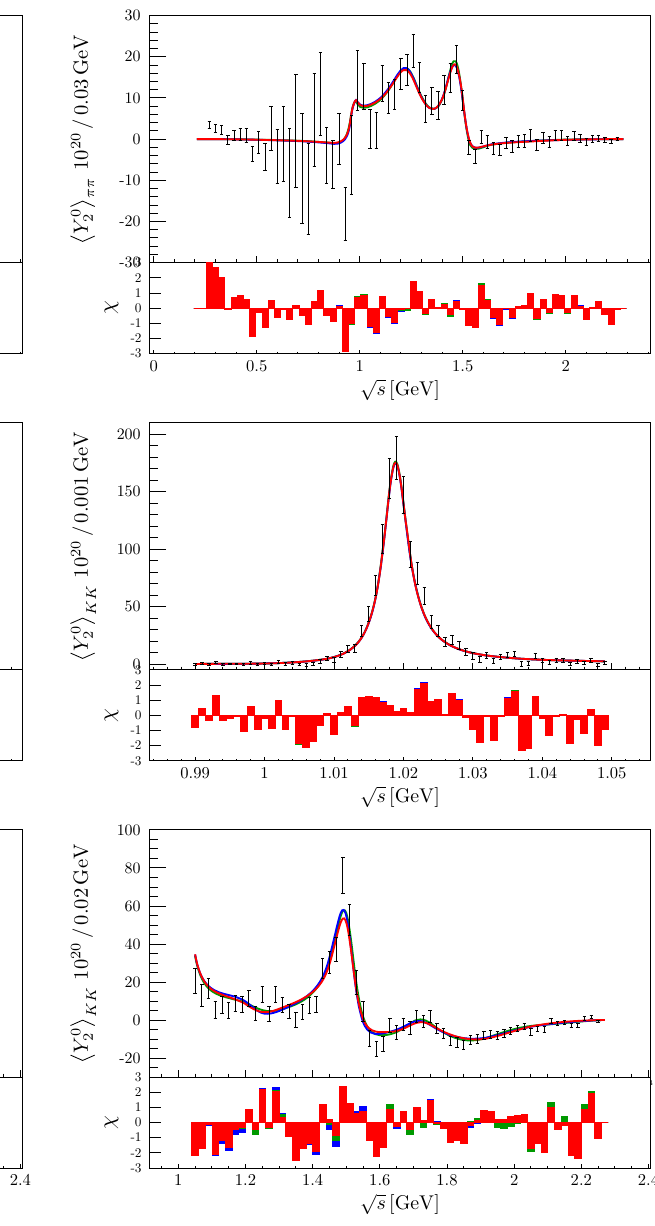
Fit 2 in red, and Fit 3 in green. On the lower axis we show the fit residuals defined by χ =